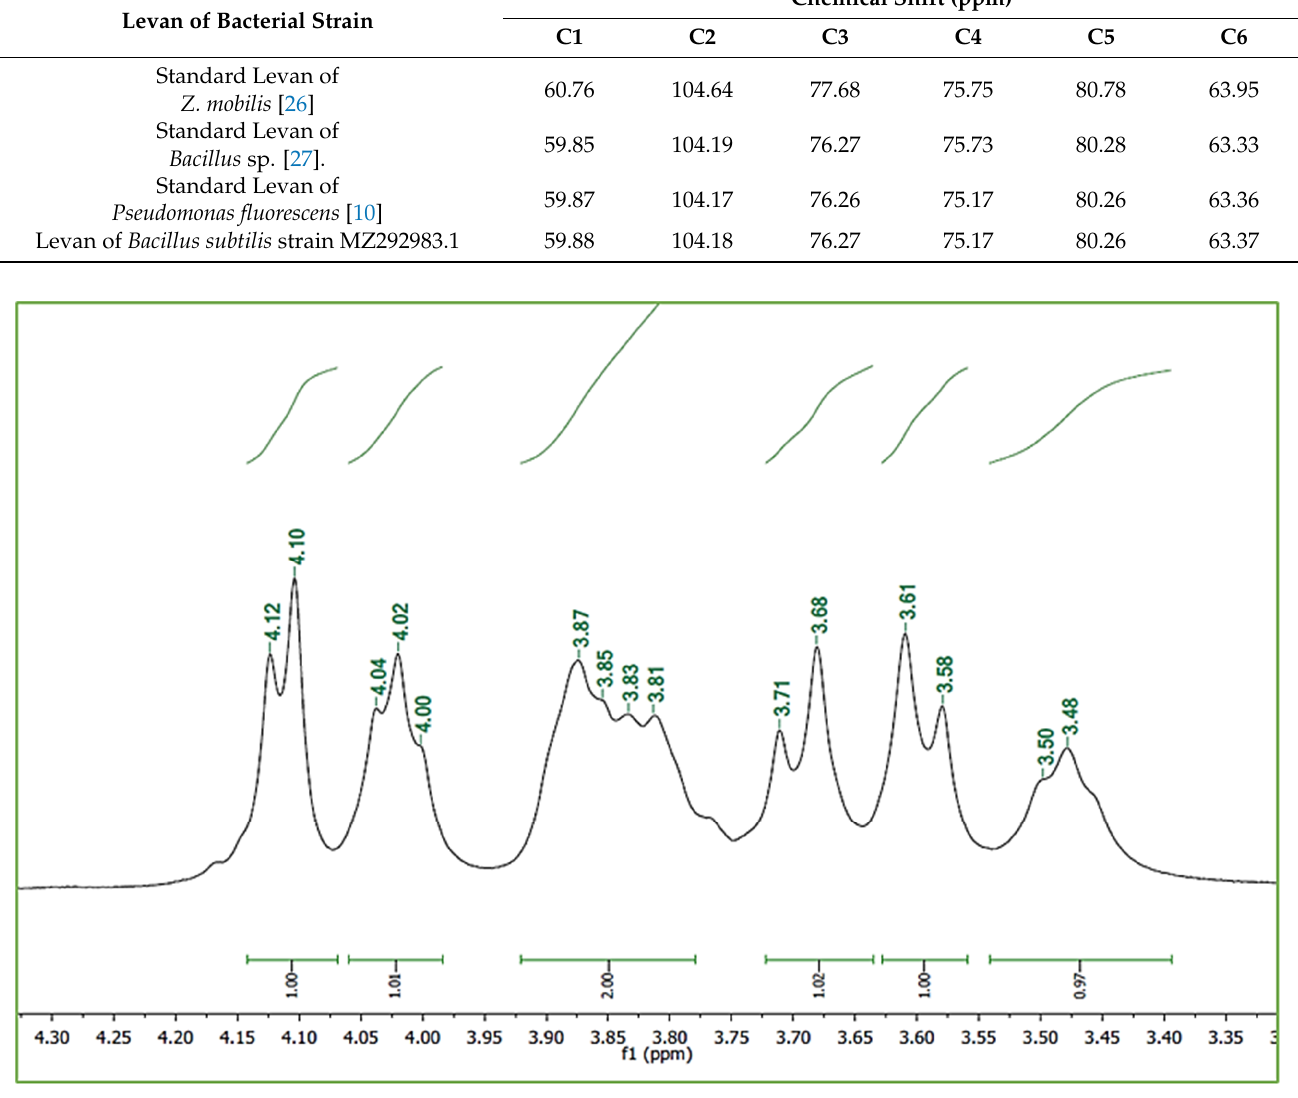
Figure 4. 13 C NMR spectrum of levan from Bacillus subtilis strain MZ292983.1. The recorded spec- trum was at 100 MHz for the sample in D 2 O. 3.4. Antibacterial Activity of Levan Levan’s antibacterial activity was evaluated in vitro against Gram-positive S. aureus (ATCC 33592) and Gram-negative E. coli (ATCC 25922). They scored inhibition zones of 1 cm and 0.8 cm, respectively. Additionally, both strains scored MICs of >256 μg mL −1 .